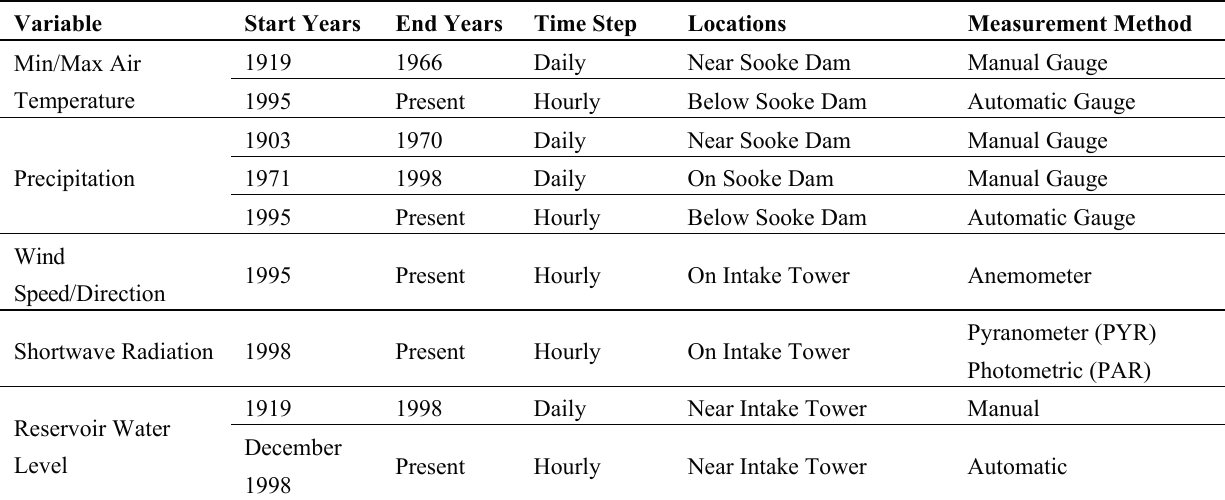
Table 1. Meta-data for measurements made in the Sooke Reservoir by the Capital Regional District (CRD)